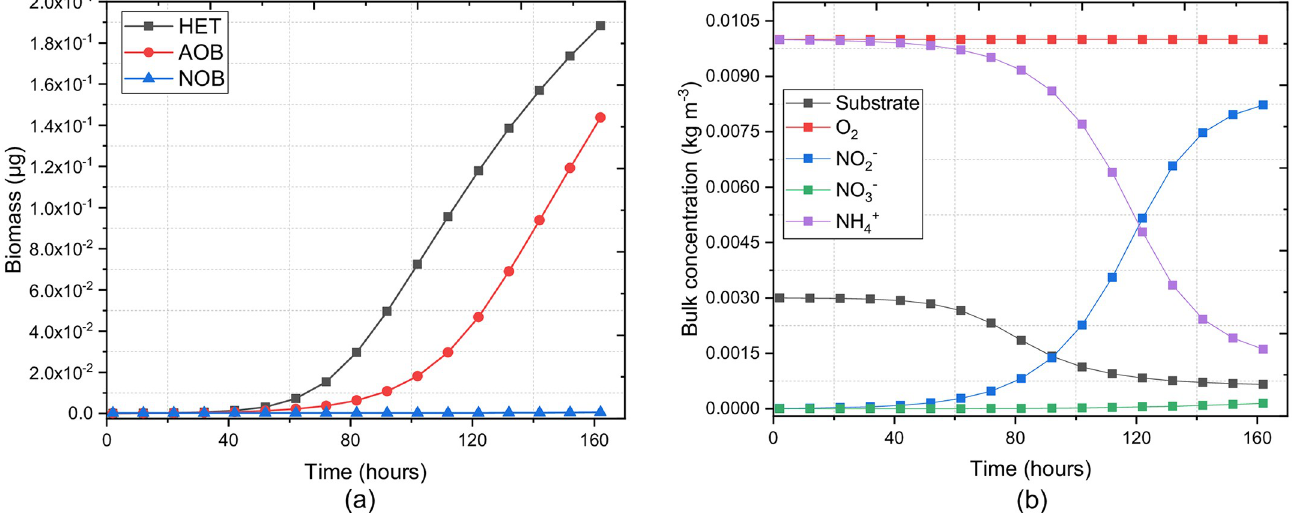
Fig 8. Quantitative evaluation of Case Study 2. (a) Total biomass of active functional groups over time, and (b) nutrients concentration in bulk liquid. Note that we assume the oxygen concentration in bulk liquid is kept constant by aeration. The slow growth of NOBs is due to the nutrient limitation, their low growth rate, and spatial distribution. At the early stage of the biofilm formation, the system is in NO 2 − limited condition. As the biofilm growth, the bottom area where NOBs reside turns to oxygen-limited condition. Both conditions inhibit NOBs growth.